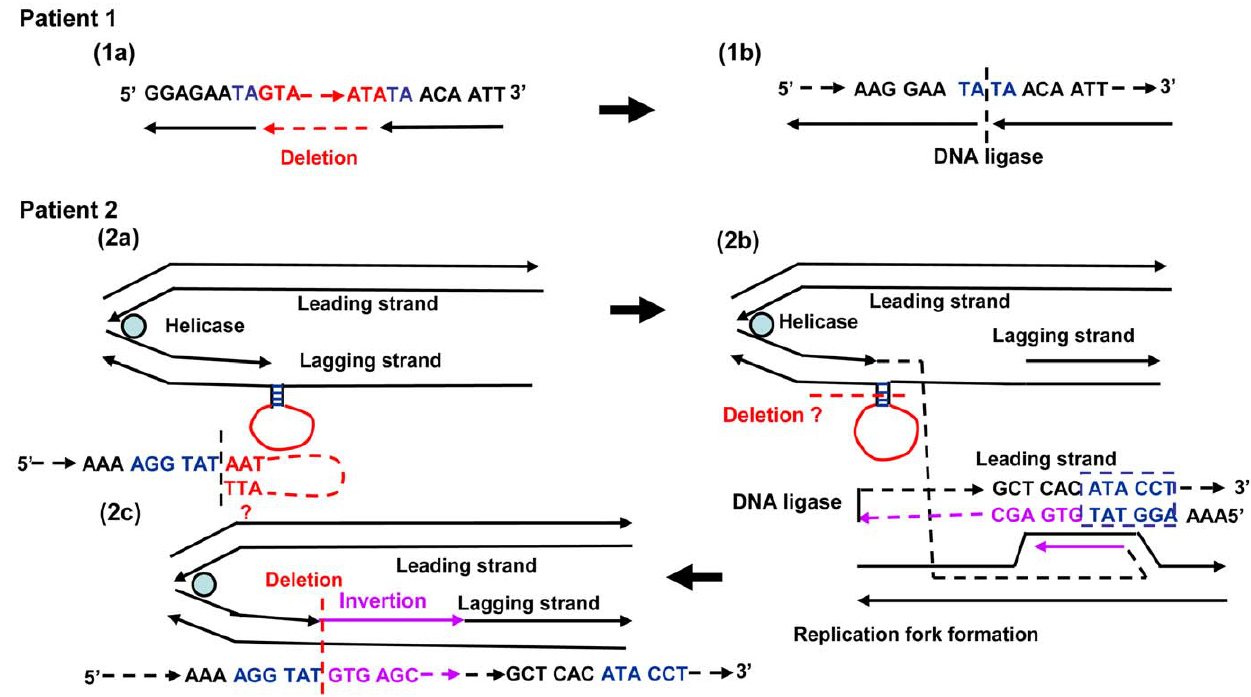
Figure 7. Genomic Rearrangement Mechanisms. For the gene deletions in patient 1, gene rearrangements exhibiting deletions due to non- homologous end-joining (NHEJ) were thought to have occurred, since repeated two base sequences of TA were observed at both ends of the gene (1a, 1b). In patient 2, it was hypothesized that rearrangement might have occurred through a mechanism involving a combination of fork stalling and template switching (FoSTeS)/microhomology-mediated break-induced replication (MMBIR). A three base repeat sequence of AAT prone to cause changes in copy number or sequence swaps was observed in a discontinuous end of the lagging strand during DNA replication. This formed a loop by binding to TTA on its complementary strand with replication slippage occurring (2a). At the discontinuous end, the lagging strand with the loop formed had a six base microhomology of AGGTAT and dissociated. The dissociated end subsequently bound to the ATACCT found at the duplication front of the leading strand. Synthesis and extension of the leading strand then occurred originating from the binding site (2b). The gene synthesized on the leading strand is hypothesized to cause structural abnormalities leading to duplications of the DNA strand subsequent to the DNA strand deletion by returning to the lagging strand after the end of duplication and the binding of the end that has finished duplication to the starting end of the normal gene on the lagging strand by DNA ligase (2c).